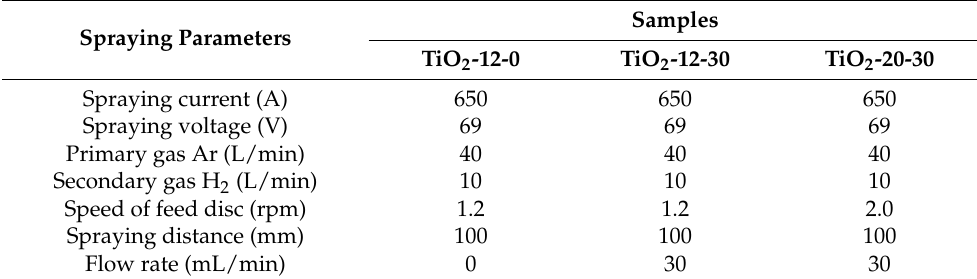
Table 1. The details of plasma spraying parameters for TiO 2